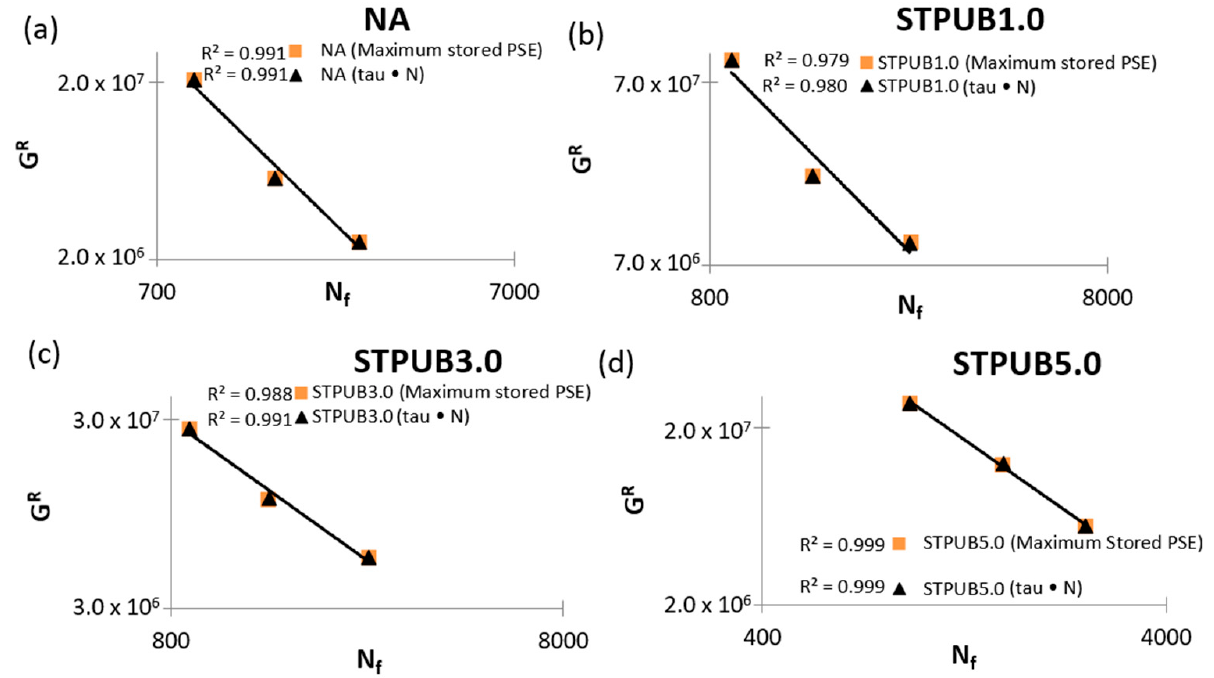
Figure 12. G R (TRPSE) vs. N f failure criterion graphs: ( a ) NA, ( b ) STPUB1.0, ( c ) STPUB3.0, and Figure 12. 𝐺 (cid:3019) (TRPSE) vs. 𝑁 failure criterion graphs: ( a ) NA, ( b ) STPUB1.0, ( c ) STPUB3.0, and ( d ) (cid:3033) ( d ) STPUB5.0.